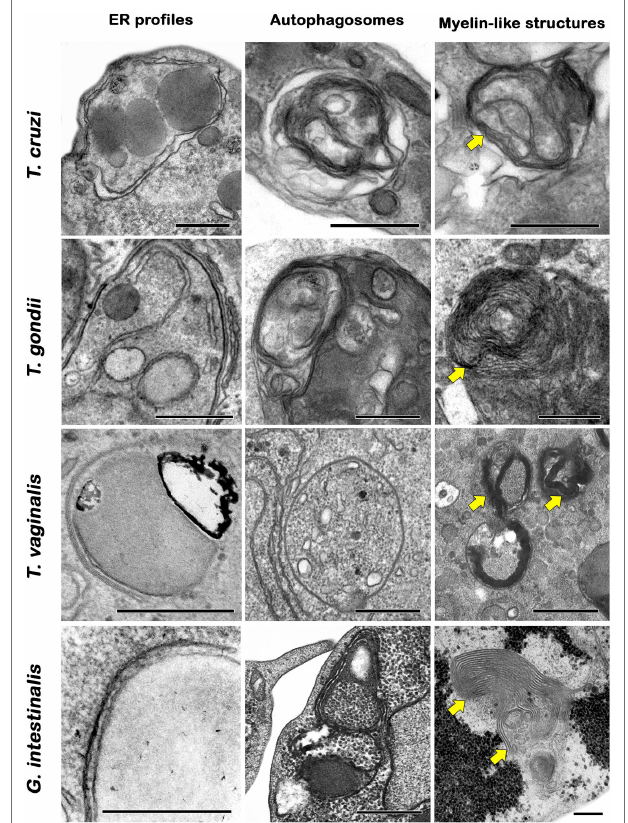
FIGURE 6 | Transmission electron microscopy analysis of autophagic phenotypes conserved in protozoan parasites. Trypanosomatids, apicomplexans, trichomonadids, and diplomonadids share similar ultrastructural features of autophagy such as endoplasmic reticulum (ER) surrounding organelles, the formation of autophagosomes and myelin-like structures (arrows). Bars = 0.5 μ m.